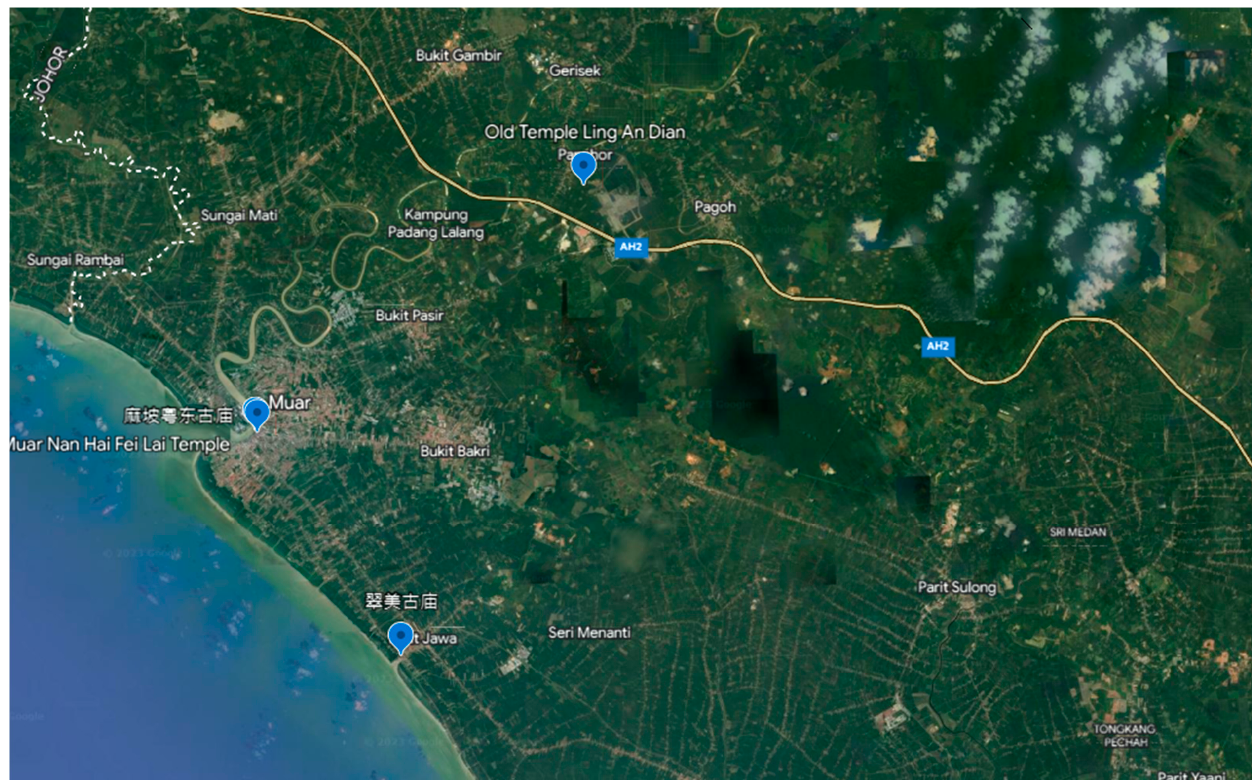
Figure 2. Muar Temples Distribution Map in 1850–1899.